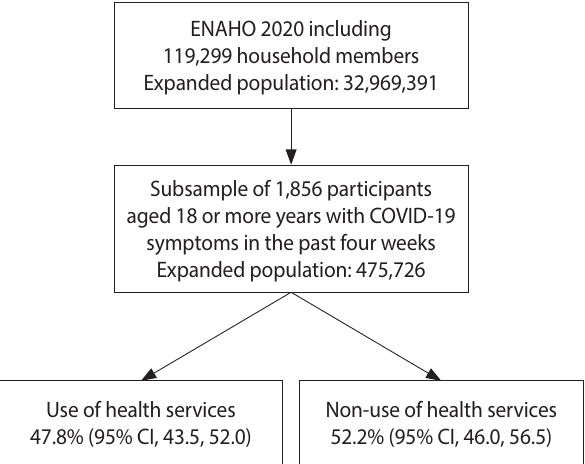
Figure 1. Flow diagram of the systematic review and meta-analysis process.